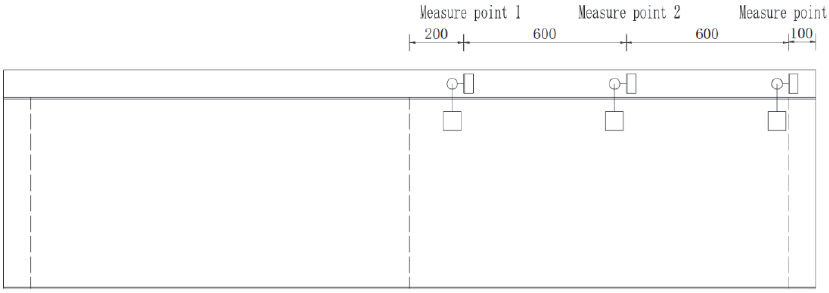
Figure 7. Real Fixing Method of Dial Gauge.